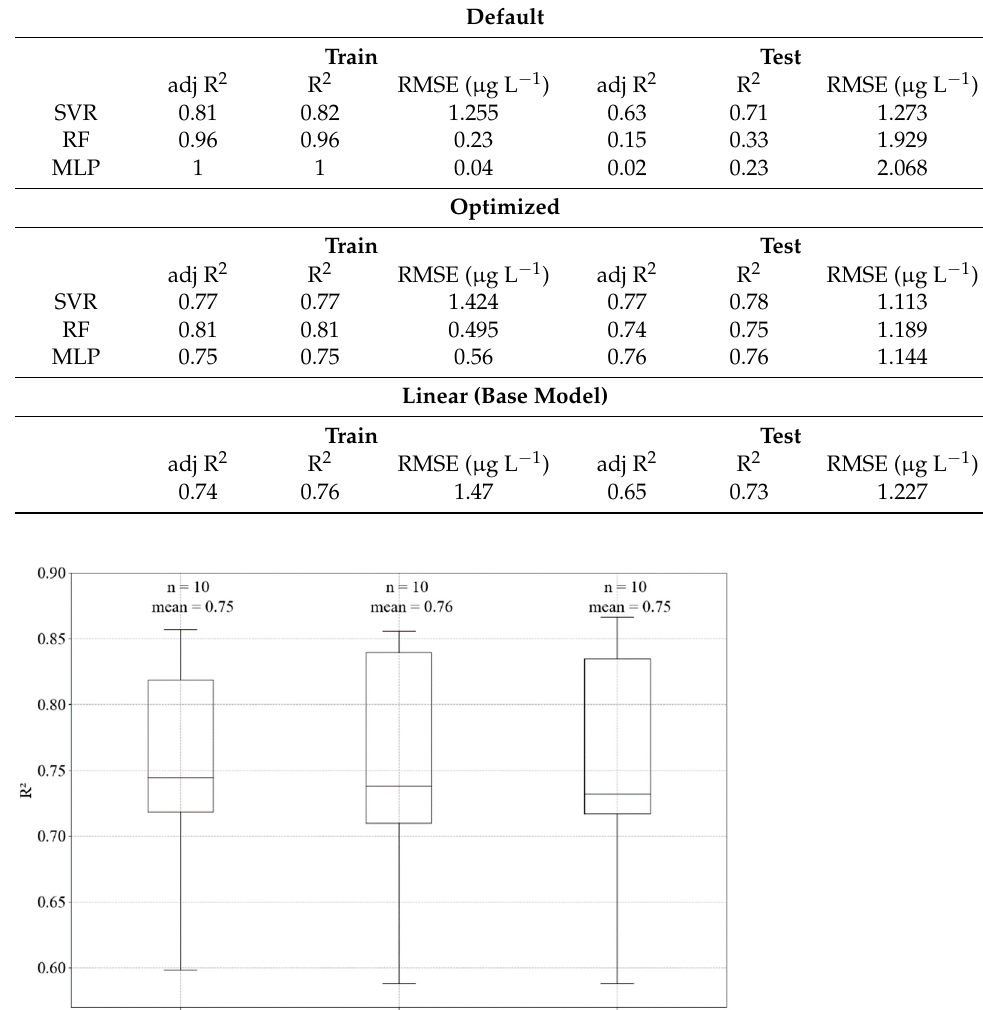
Figure 4. Boxplot of accuracy in the 10-fold cross-validation training step for the SVR, MLP and RF models, showing the mean and the number of folds (n) or subsets in the training data used to define the best hyperparameters.